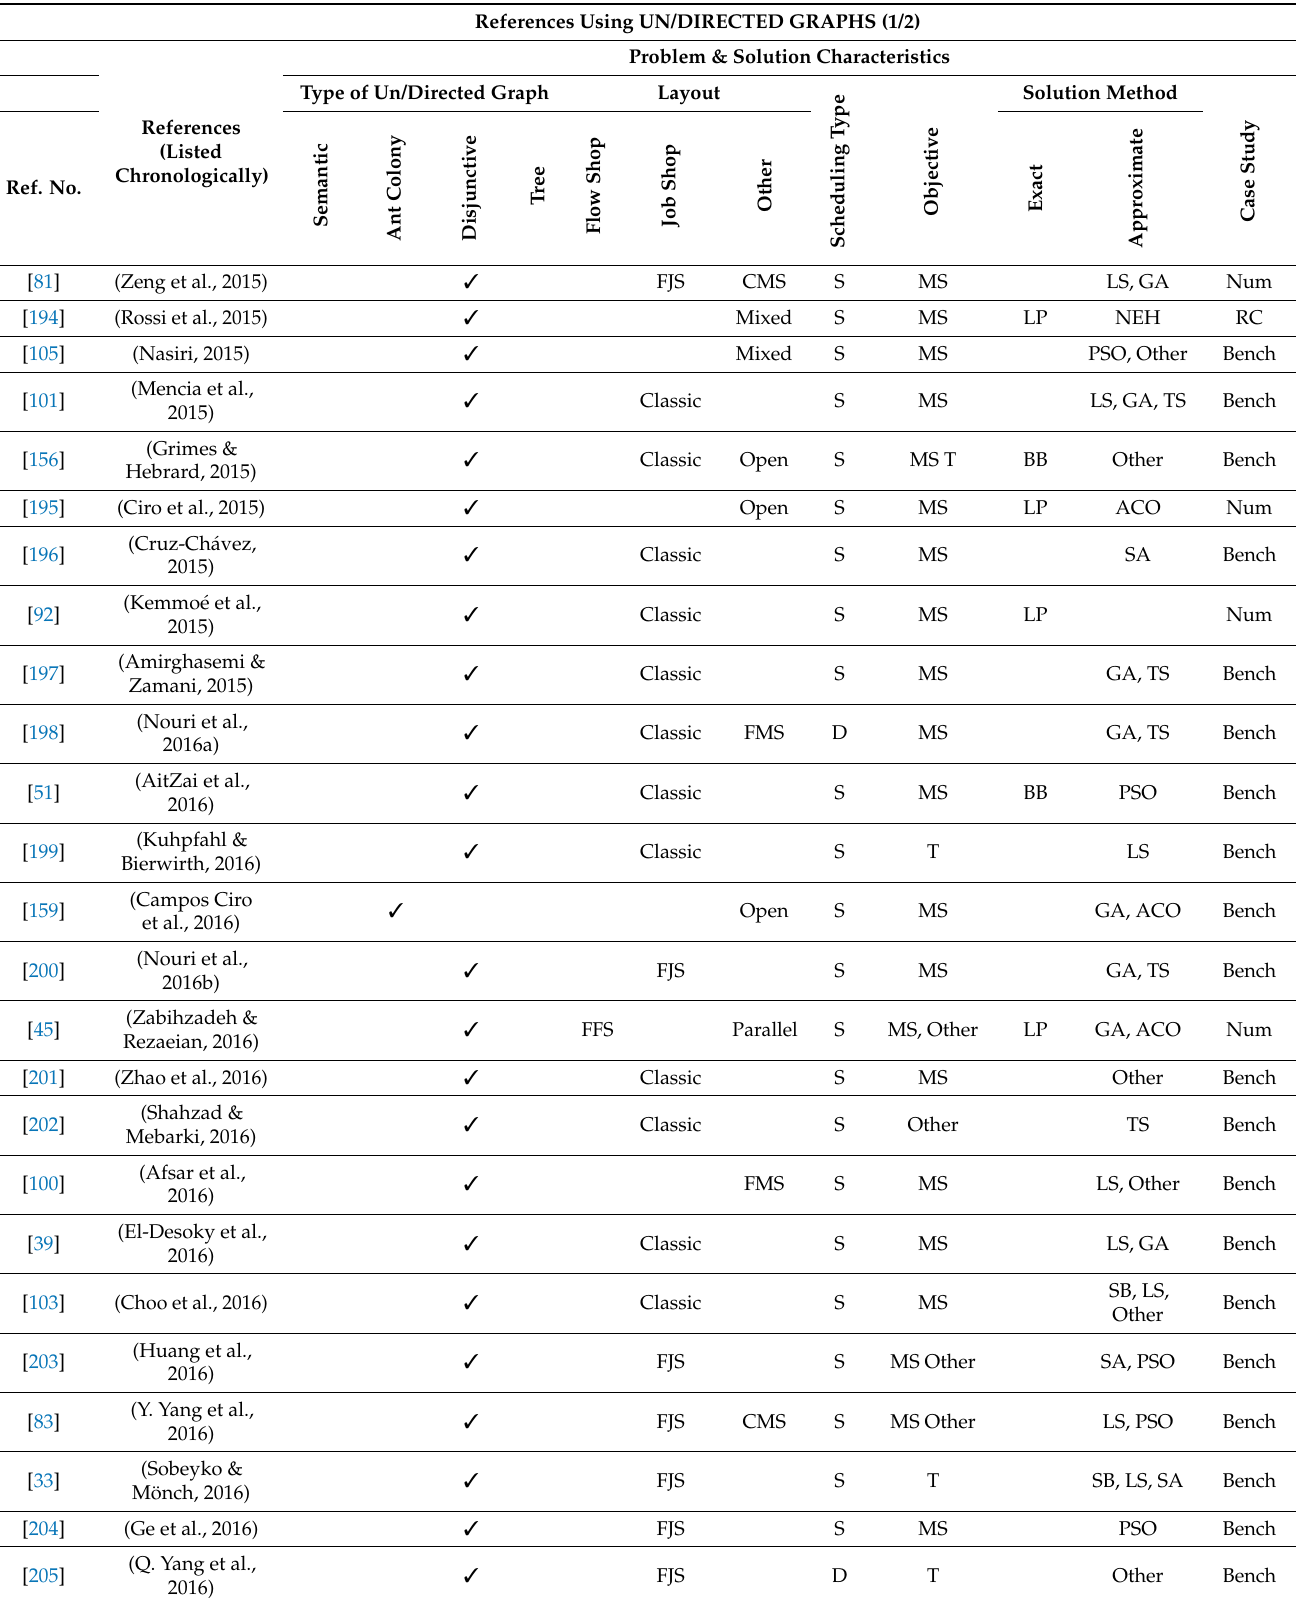
Table 8. Overview of references in the dataset using Un/Directed